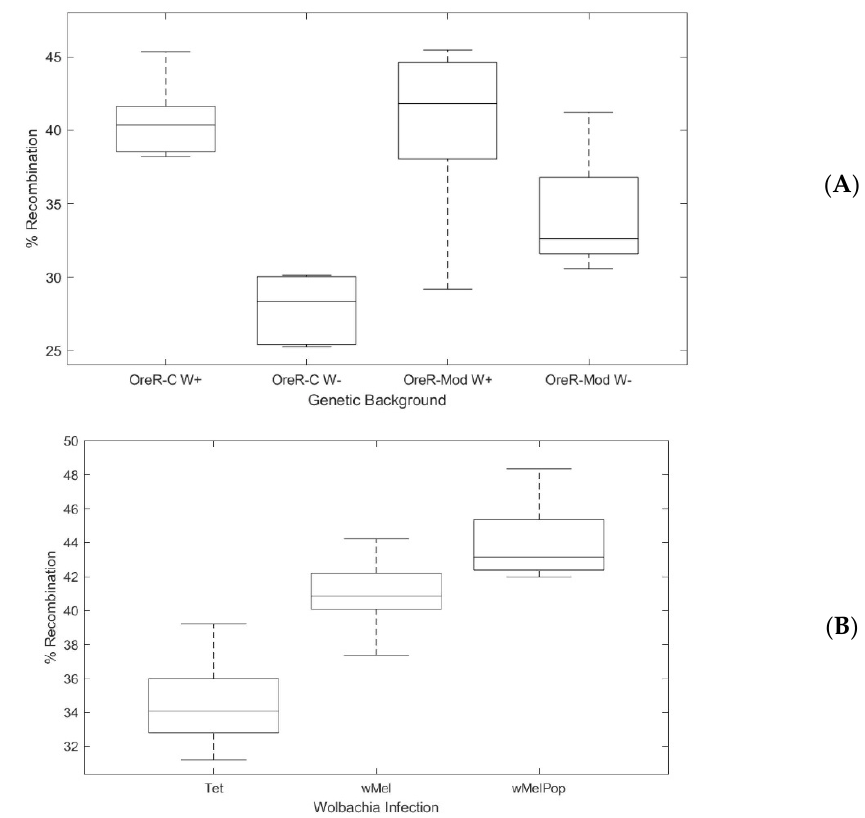
Figure 3. Wolbachia increase in recombination is titer depedent and independent of fly genetic background. ( A ). Percentage of recombinants observed based on genetic markers on the X chromosome of Drosophila in two different genetic backgrounds, OreR-modENCODE (BDSC stock #25211)and OreR-C (BDSC stock #5), shown as box and whisker plots. Wolbachia infection significantly increased the recombination rate observed in both genetic backgrounds. Significance was determined by logistic regression OreR-modENCODE (df = 1, χ 2 = 16.363, p < 0.001) and OreR-C (df = 1, χ 2 = 4.461, p = 0.035). ( B ). Box and whisker plots showing percentage of recombinants observed, based on genetic markers on the X chromosome of Drosophila , when Wolbachia titer is varied. A uniform genetic background was used for comparisons across Wolbachia -uninfected (Tet) flies, Wolbachia infected ( w Mel) flies, and flies infected with a high-titer variant ( w MelPop) (see Figure S1). Increased Wolbachia increased recombination in a load-dependent manner by 6.3% for w Mel and 9.5% for w MelPop (df = 3, χ 2 = 33.4, p < 0.001). Significance between Tet and w Mel (U=1.0, Z= − 3.064, p = 0.002), w Mel and w MelPop (U=8, Z= − 2.870, p = 0.004), and Tet and w MelPop (U=0, Z= − 3.182, p = 0.001) was determined with Mann-Whitney U test implemented in SPSS.